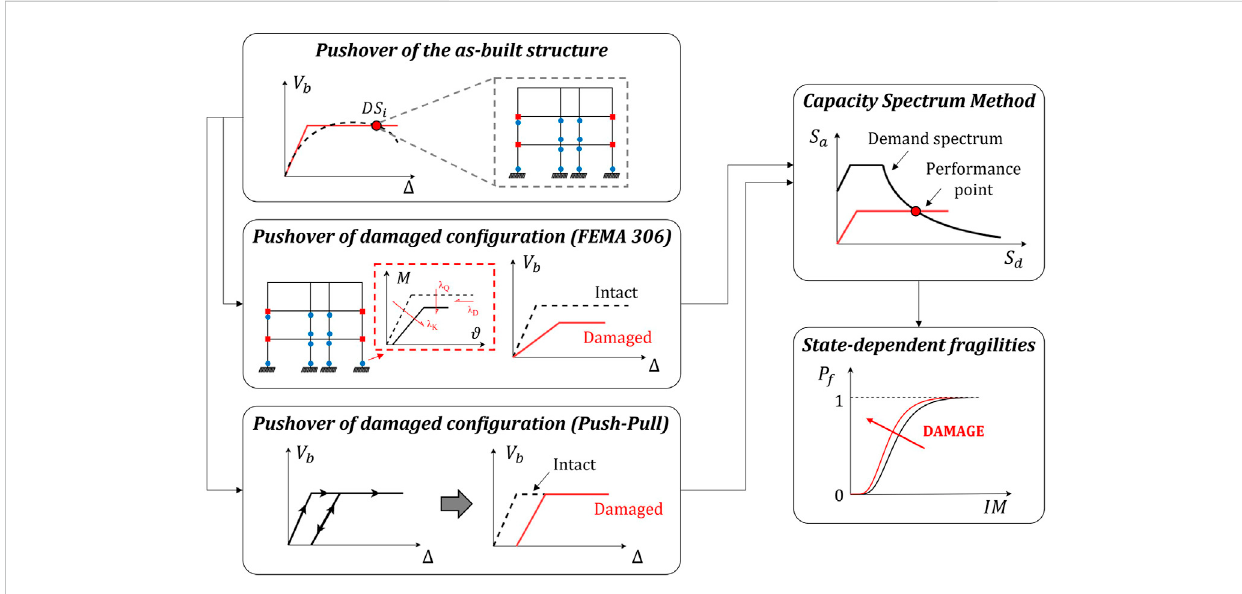
FIGURE 6 Conceptual illustration of frameworks for state-dependent fragility analysis based on non-linear static